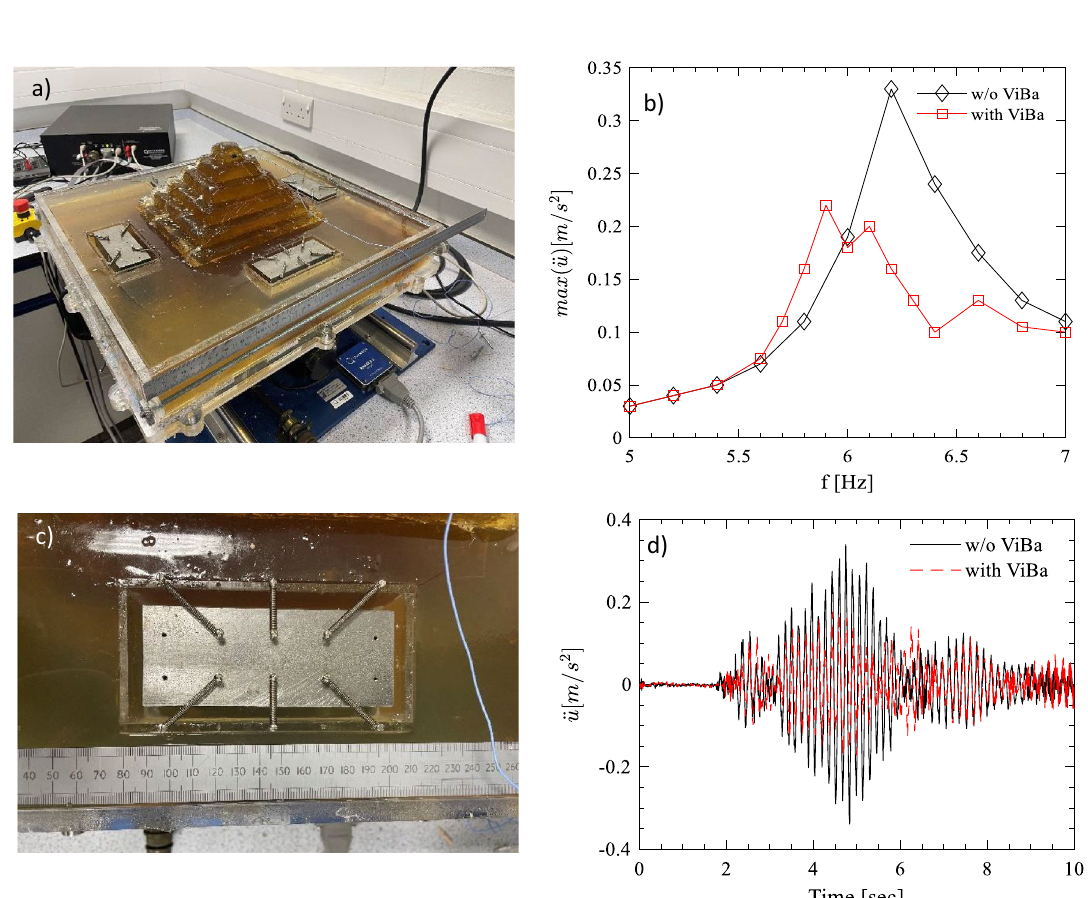
Figure 8. Experimental test on the 1:500 model of the Zoser pyramid: ( a ) test setup; ( b ) frequency response function with and without the ViBas; ( c ) an example of ViBa setup; ( d ) comparison of the acceleration at the top of the pyramid forced by a simulated Cairo earthquake sample (using the Boore 28 method) showing a reduction of the peak acceleration of about 33% after ViBa